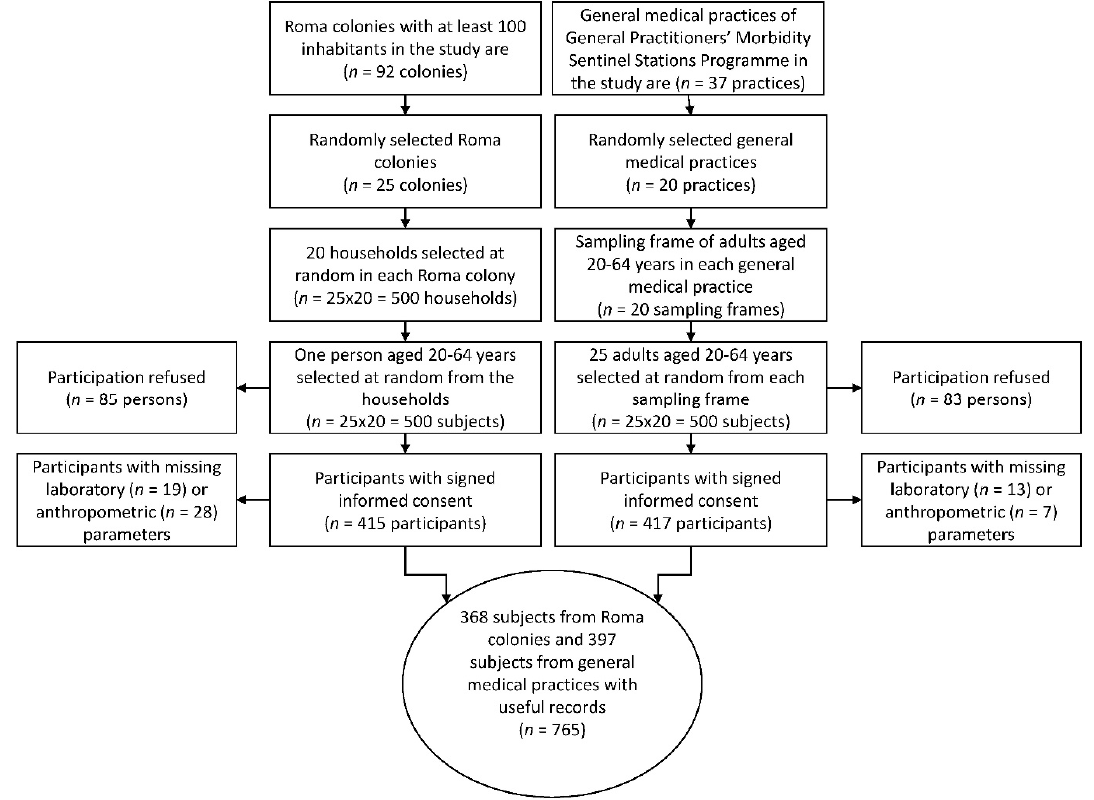
Figure 1. Flowchart showing the process of sample selection for study populations.